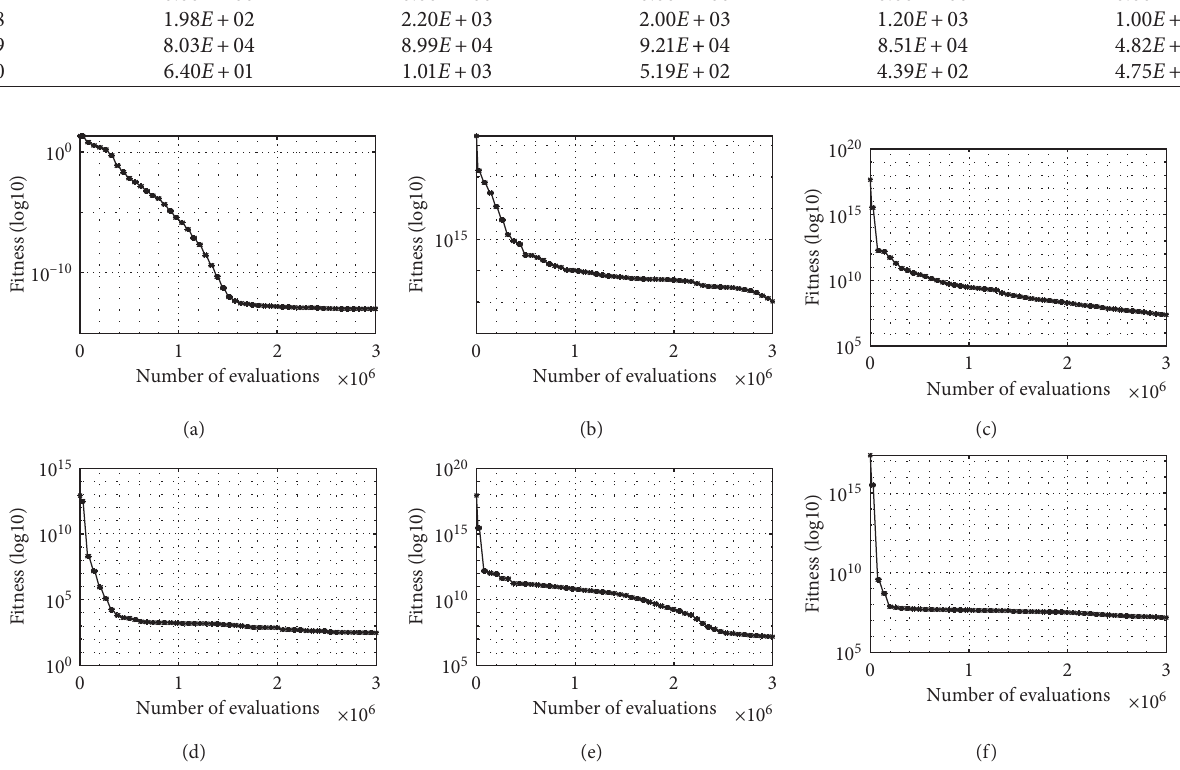
Figure 1: Convergence behavior of GI-ES using CEC2013. f3 as fully separable, f8 and f11 as partially separable functions, f12 and f14 as overlapping functions where D � 905, and f15 as fully non-separable functions. (a) Function # 3, (b) Function # 8, (c) Function # 11, (d) Function # 12, (e) Function # 14, and (f) Function # 15.